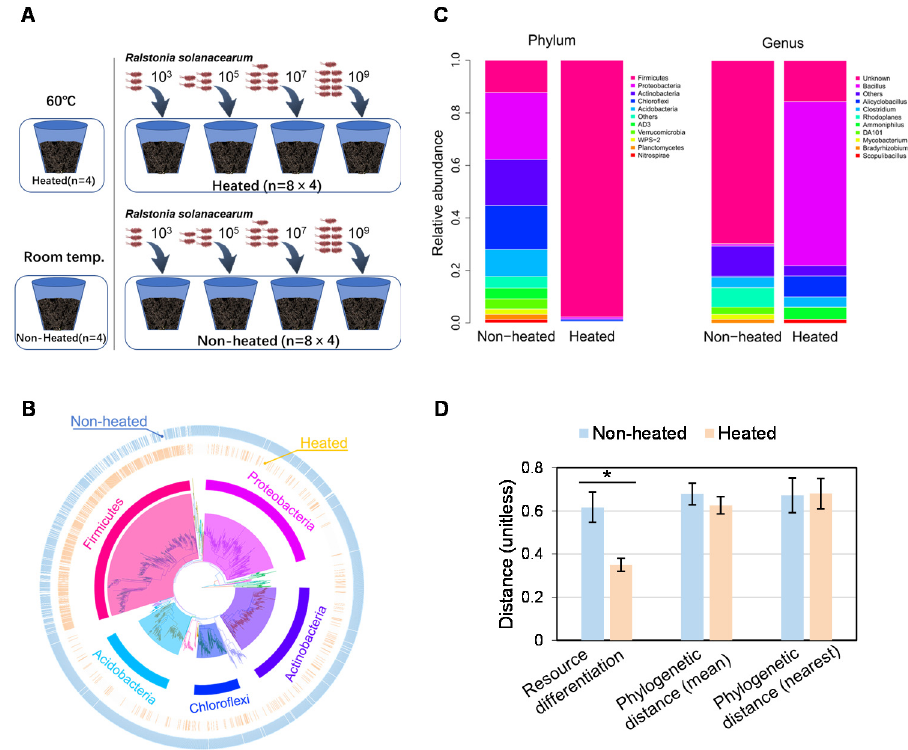
Figure 1. Schematic of the experimental design and the effects of heating on the characteristics of the pathogen and the indigenous soil bacterial community. The pathogen R. solanacearum was added to the soil, which was heated or not, at the indicated inoculum sizes, i.e., forming final concentrations of 10 3 , 10 5 , 10 7 , and 10 9 CFU · g − 1 dry soil ( A ). The phylogenies ( B ) and community composition ( C ) of bacterial communities in non-heated and heated soils. A heatmap showing the presence/absence of the tip in non-heated and heated soils has been appended at the outer and inner ring, respectively, in Panel C. The resource differentiation was calculated as the difference in carbon utilization substrates in Biolog, and the phylogenetic relatedness (the mean and the nearest phylogenetic distance calculated using the phylogenetic tree) between R. solanacearum and indigenous bacteria ( D ). Values are presented as means ± sd, * representing significant differences between non-heated and heated soils ( p < 0.05, t-